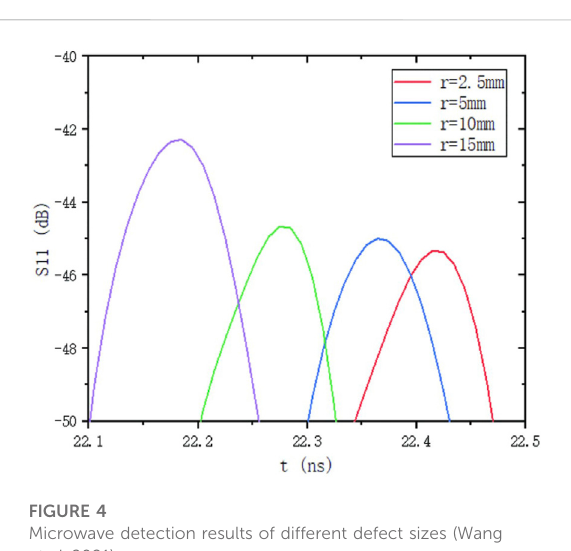
FIGURE 4 Microwave detection results of different defect sizes (Wang et